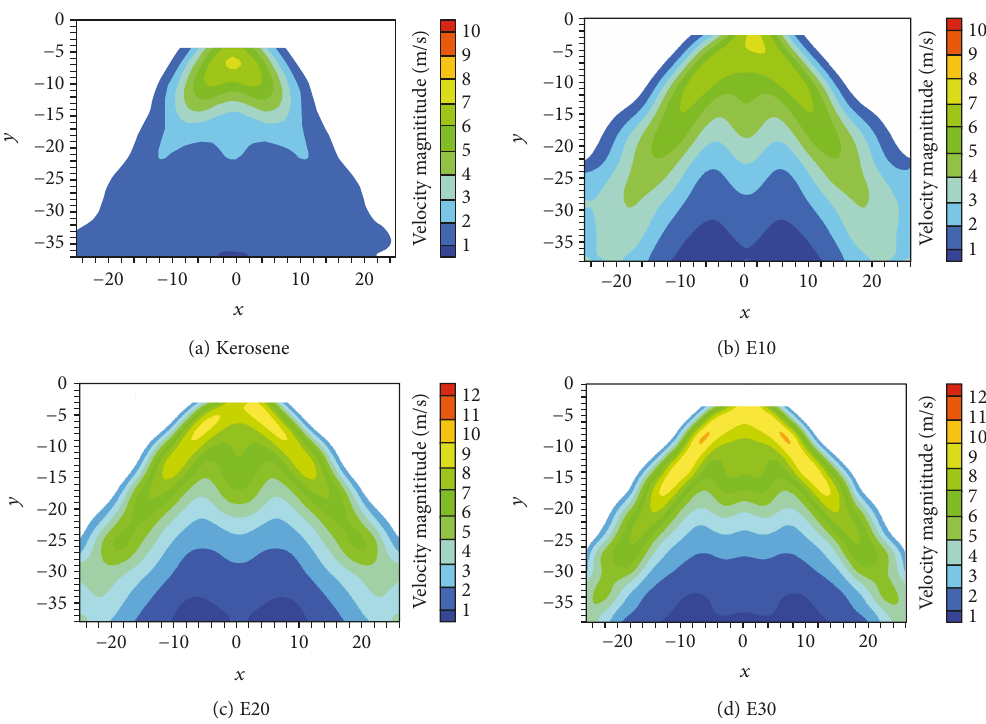
Figure 13: Velocity magnitudes at